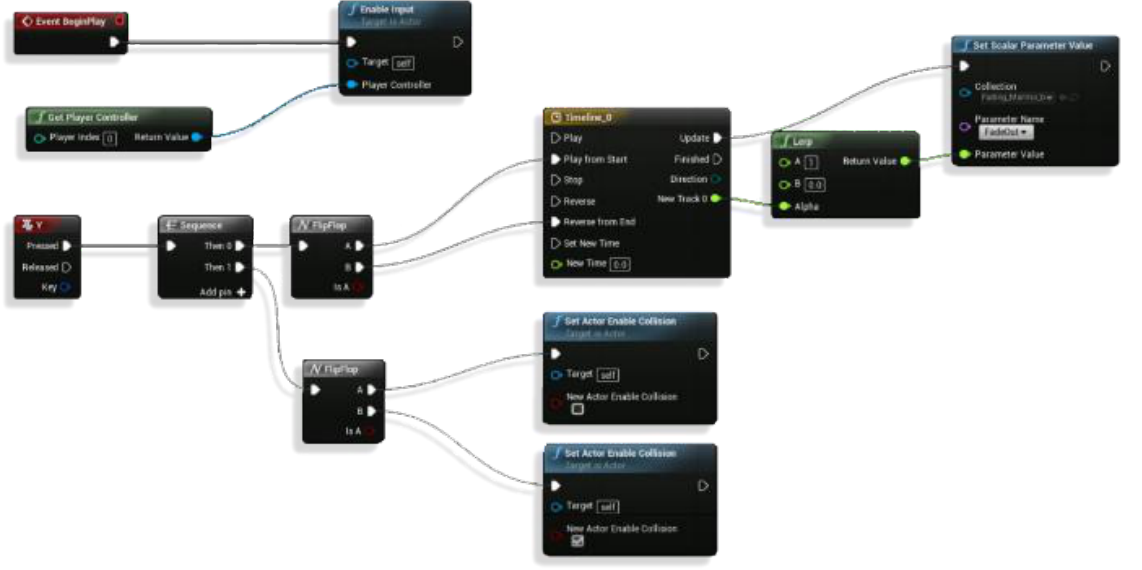
Fig. 11: Blueprint of fading/reappearance of the element.